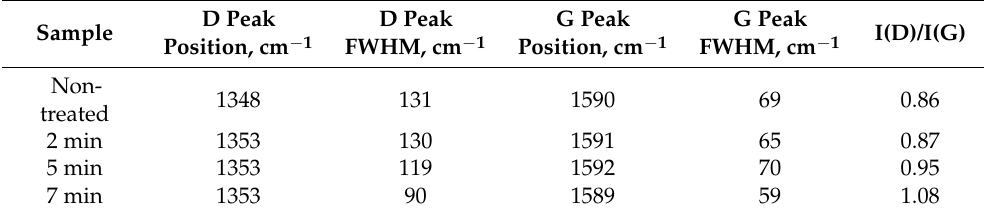
Figure 3. ( a ) Raman spectra of samples obtained using various durations of plasma treatment. ( b ) I-V curves of the active layer of the gas sensor. ( c ) Typical response curve of pristine MWCNTs and MWCNTs plasma-treated for 2 min. Table 1. Parameters of Raman spectra of plasma-treated MWCNTs.